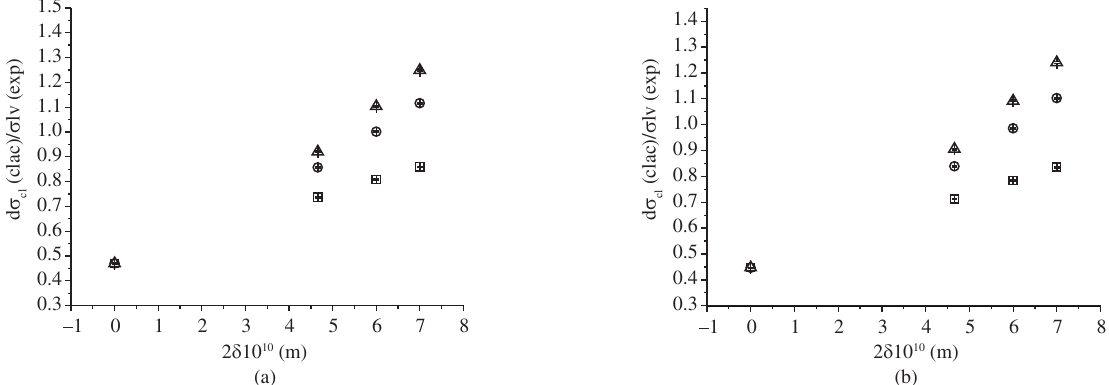
Figure 6. Comparison of σ were